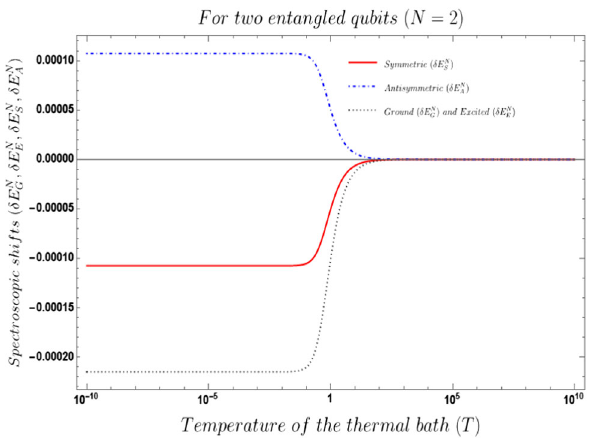
Fig. 2 Behaviour of spectroscopic shifts wrt the temperature of the thermalbath.Theotherparametersarekeptfixed( ω = 0 . 5 , L = 1 ,μ = 0 . 1 ,ω 0 = 1)